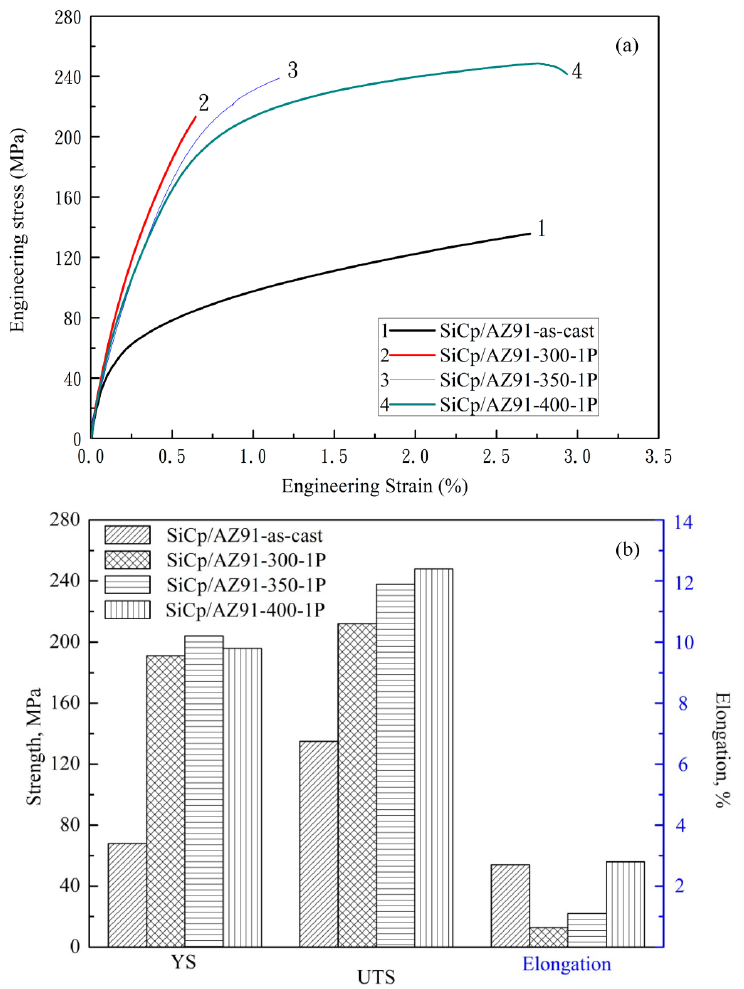
Figure 5. ( a ) The engineering stress–engineering strain curves and ( b ) tensile strength of the nano- SiCp/AZ91 composites after single-pass forging under different temperatures. nano-SiCp/AZ91 composites after single-pass forging under different